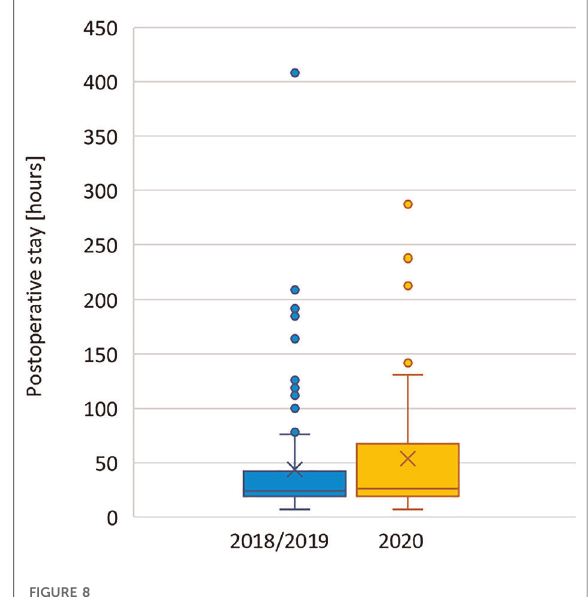
FIGURE 8 Length of postoperative stay in 2018/2019 and